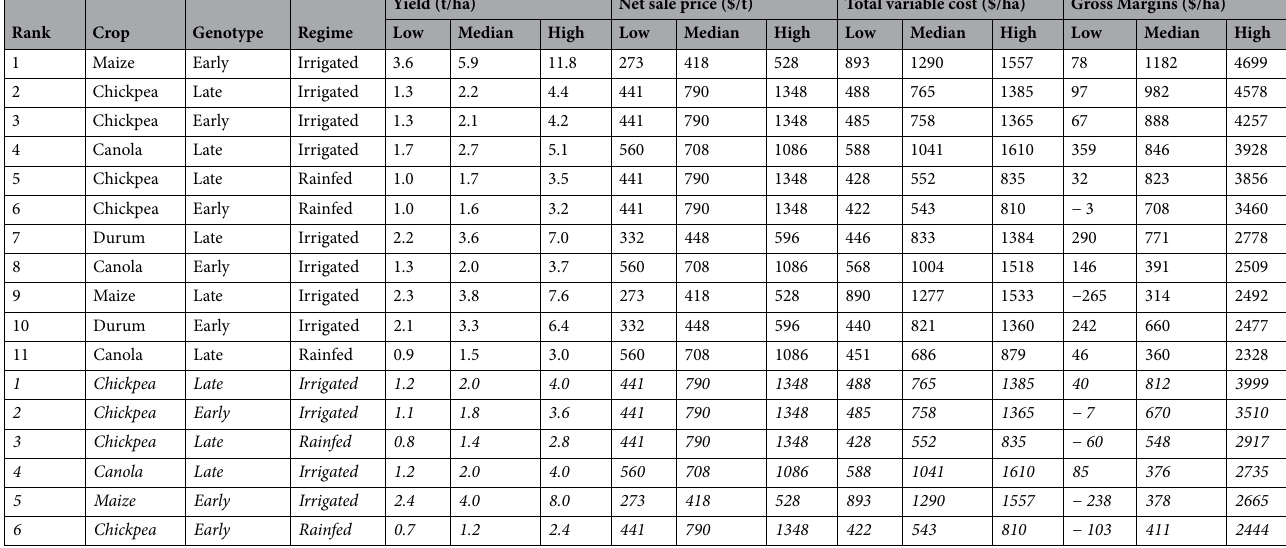
Table 6. Crop gross margin ranking under current and future climates as a function of yields, real prices and variable costs for a hot dry region (Kerang) for historical (white rows, 1985–2021) and future (itallic rows, 2070–2089) climates (other regions shown in Table